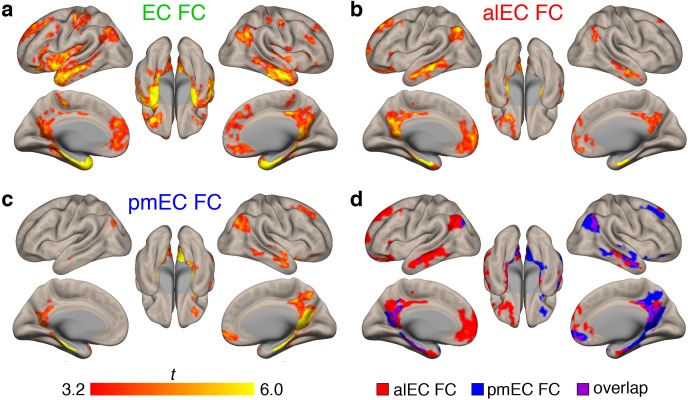
Functional connectivity (FC) of the different entorhinal seeds in older adult (OA) participants.Seed-to-voxel FC analyses were performed for each seed. Group level FC results were derived from one-sample t-tests controlling for age and sex, and thresholded at the voxel (p<0.001 uncorrected) and cluster (p<0.05 FDR corrected) levels. Results reflect t-statistics. (a) FC of the EC seed included medial temporal, lateral temporal, and limbic regions. The dice similarity coefficient (DSC) between the YA and OA EC maps was 0.45, reflecting moderate overlap. (b) FC of the alEC seed included anterior temporal regions, as well as some posterior medial regions such as the posterior cingulate cortex. DSC between YA and OA alEC maps was 0.36, reflecting fair overlap. (e) FC of the pmEC seed included posterior medial regions, although reduced in scope compared to YA FC patterns. DSC between YA and OA pmEC maps was 0.53, reflecting moderate overlap. (f) Binary maps of the alEC (red) and pmEC (blue) FC show spatial overlap (purple) between the FC patterns, especially in posteromedial cortex.